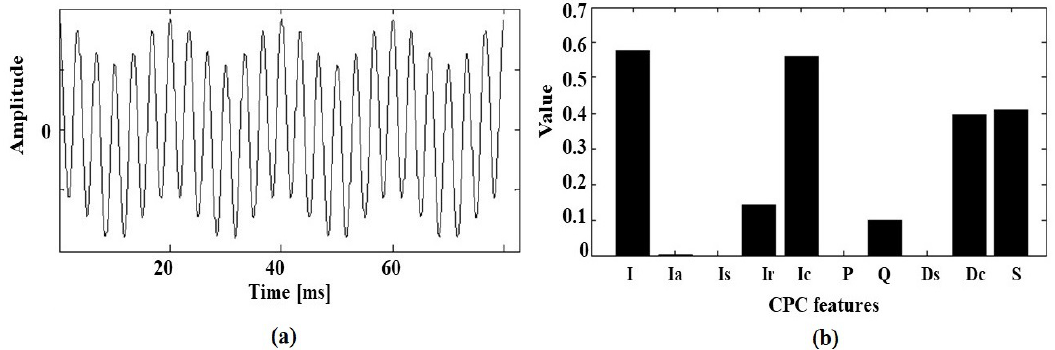
Figure 6. Filter: ( a ) simulated current waveform; and ( b ) CPC